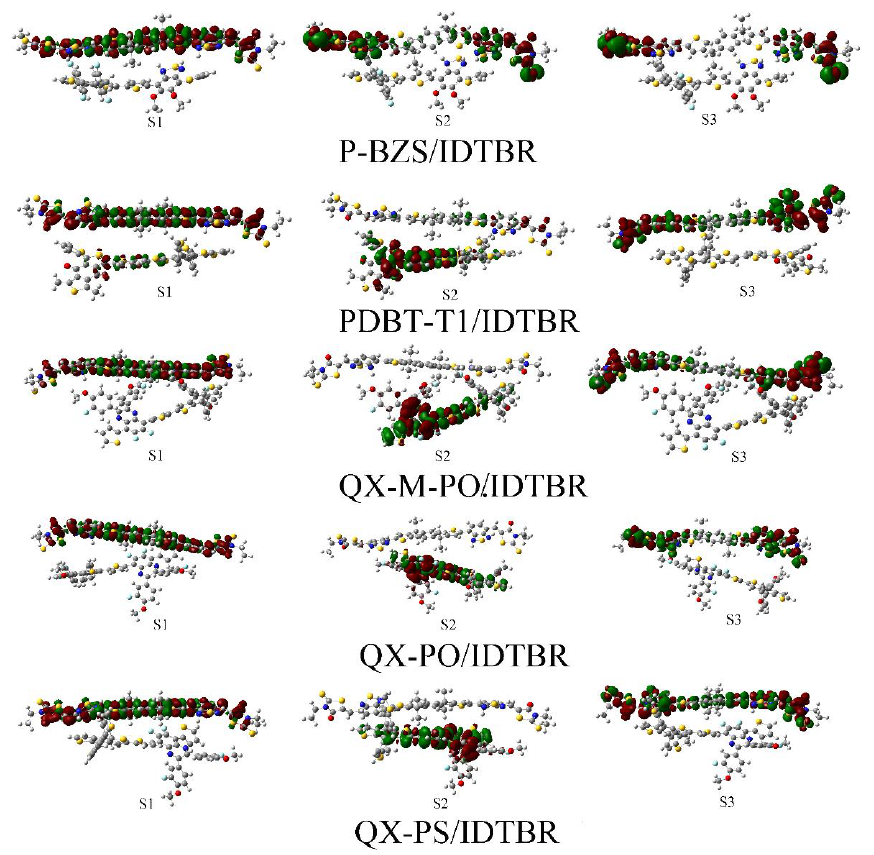
Figure 12. Charge difference densities (CDD) plots of polymer/IDTBR interfaces (S1–S3), where red represents electrons and green represents holes.